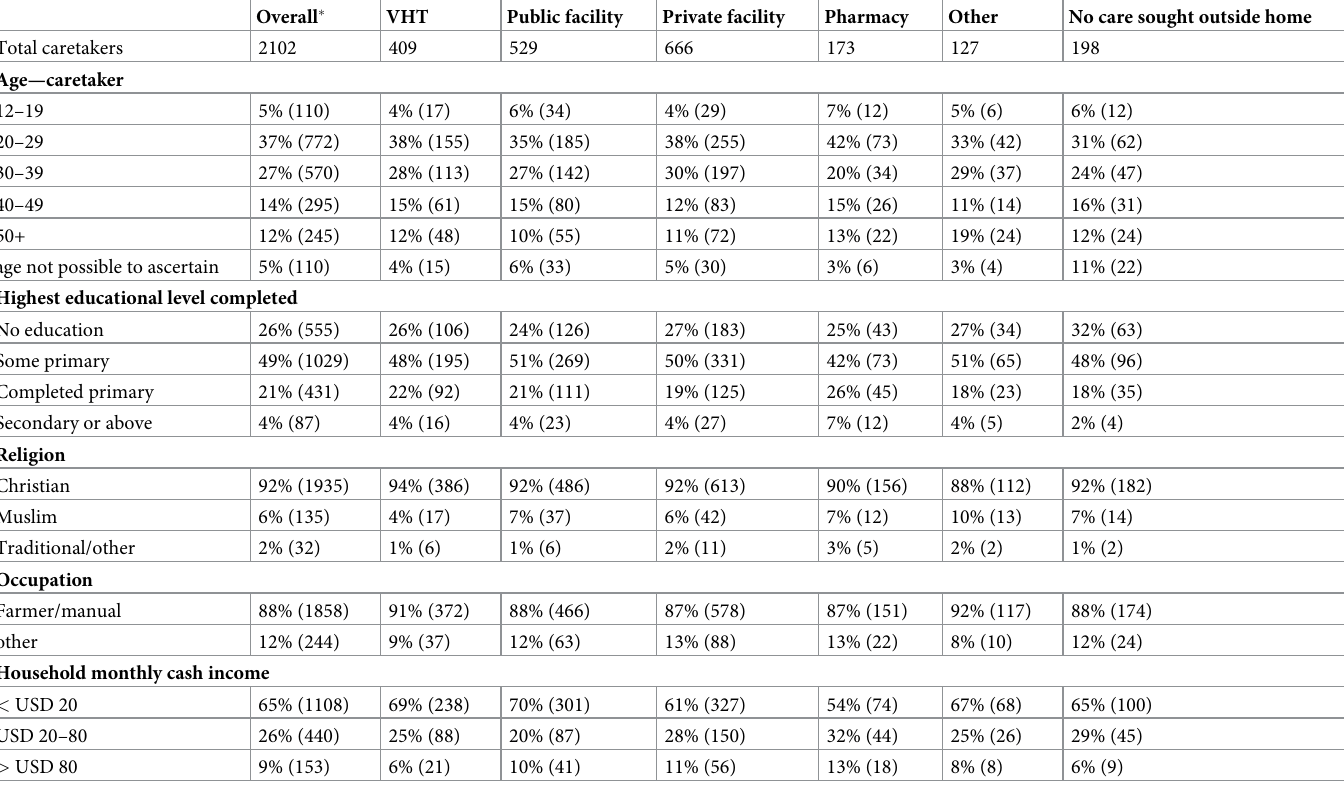
Table 2. Socio-demographic characteristics of caretakers of children with suspected malaria, diarrhoea, or suspected pneumonia; overall, and by first care seeking location. Overall �